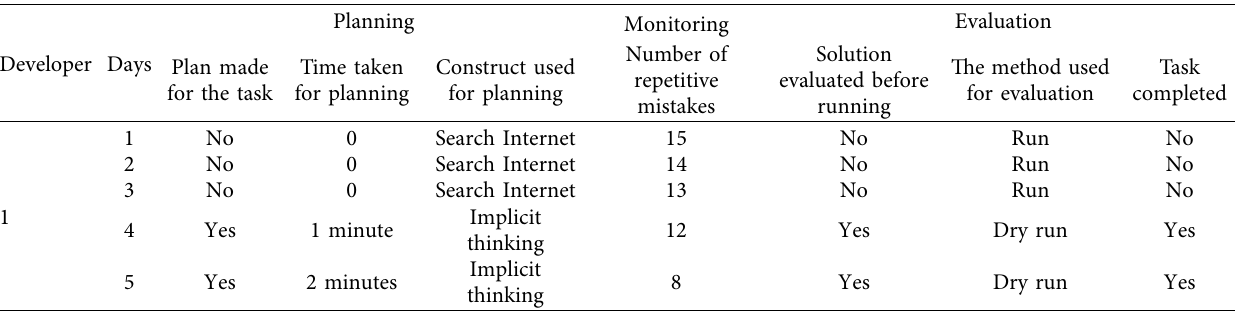
Table 4: Developer planning, monitoring, and evaluation data.